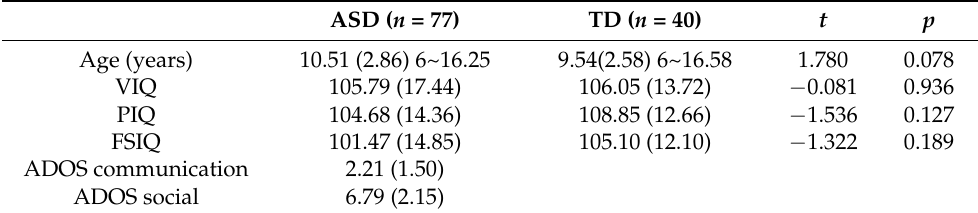
Table 1. Demographic data.